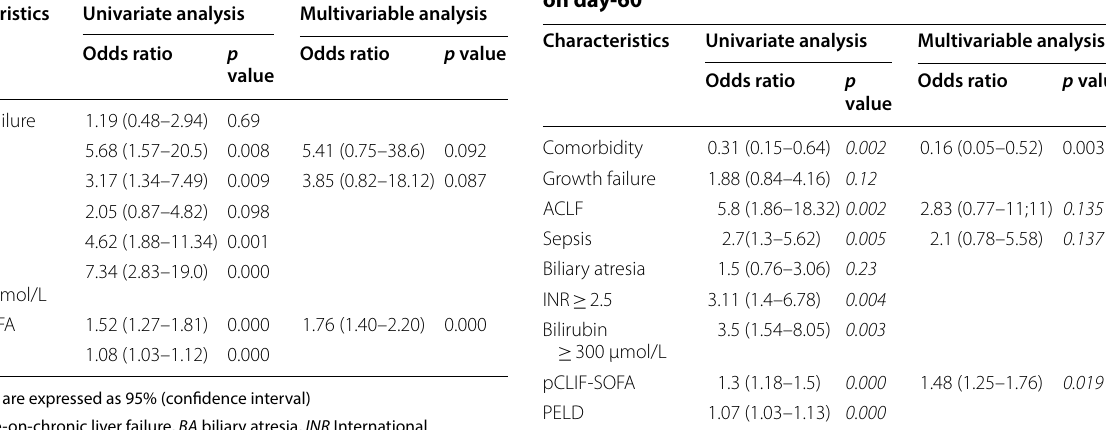
Table 5 Risk factors for composite outcome ( n versus survival without liver transplantation ( n on day-60